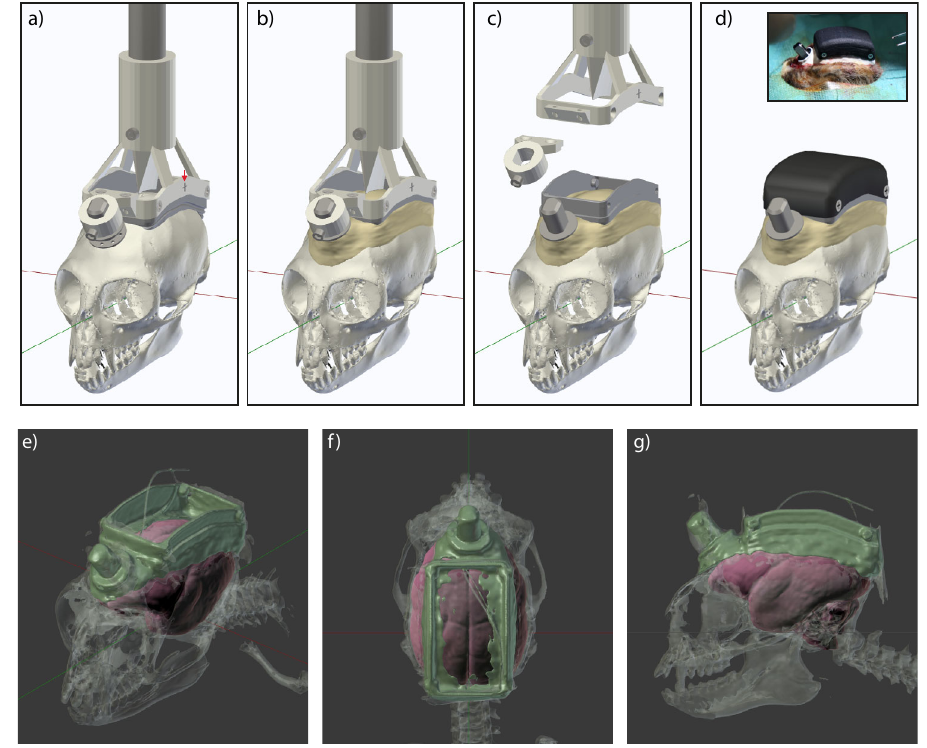
Fig. 3 | Surgery 1: Implantation of chamber and headpost. a Chamber and headpost were held by a custom implantation holder that was attached to a micromanipulator. Note the cross-shaped markers on the side of the holder, used for alignment to the interaural axis, prior to the surgery (red arrow). A wedge- shaped guide pointing downwards in the center of the holder was used for med- iolateral alignment to the central skull suture. b Following skull preparation, the aligned chamber and headpost were cemented onto the skull. c Once the cement had hardened, chamber and headpost were released from the holder. d The